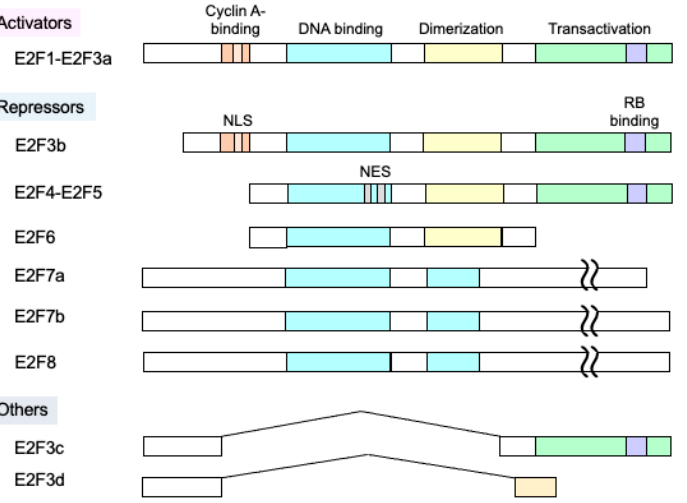
Figure 1. Structure of E2F family members. There are eight E2F family members (E2F1-E2F8), which are divided into activator E2Fs (E2F1~E2F3a) and repressor E2Fs (E2F3b~E2F8). Activator E2Fs are mainly involved in the induction of target gene expression at the G1/S boundary, free from RB.